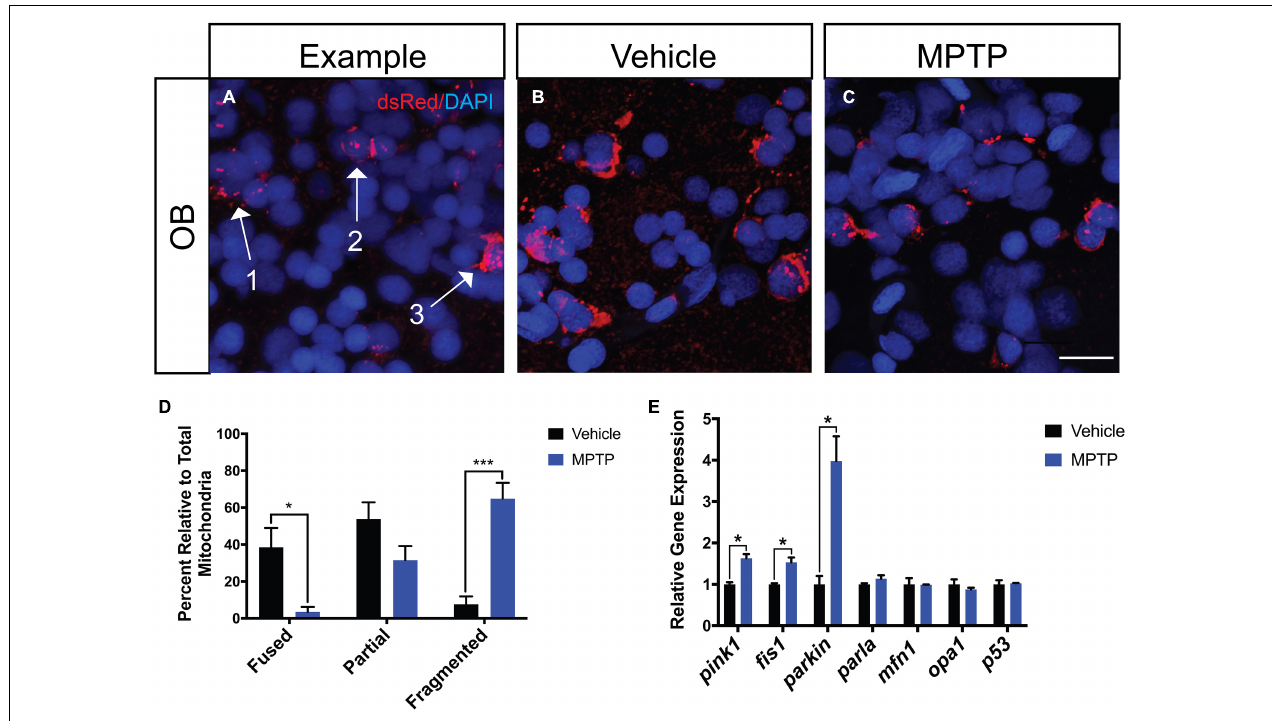
FIGURE 2 | Effect of MPTP on mitochondrial fission-fusion dynamics in Tg( dat:tom20 MLS:mCherry ) adult zebrafish. (A) Representative image depicting fragmented mitochondria (Arrow 1), partially fragmented mitochondria (Arrow 2), and fused mitochondria (Arrow 3). (B,C) Immunohistochemical labeling marked mCherry+ for mitochondrial visualization and nuclei with DAPI+ on coronal OB cryosections from vehicle and MPTP injected zebrafish. (D) Proportion of fused, partially fragmented and fragmented mitochondria ( n = 4 ). (E) Whole brain qRT-PCR analysis for mitochondrial and apoptotic genes; mao-b , pink1 , fis1 , parkin , parla , mfn1 , opa1 , and p53 ( n = 3 whole brains from each respective group). Scale bar = 10 µ m. Bars represent the mean ± the SEM. * p < 0.05, *** p <